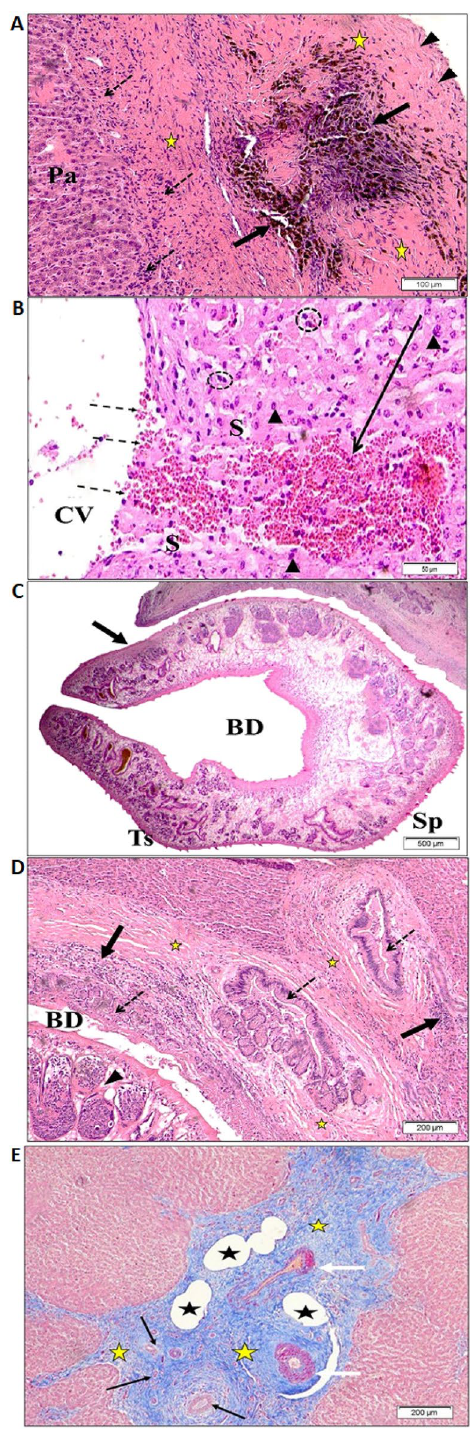
Figure 6. Light microscopic photographs of infected sheep liver stained with H&E. ( A ) thickened fibrous capsule (arrowhead) and capsule region of dark brownish hemosiderin pigment (arrows) with the marked proliferation of fibrous connective tissue (yellow stars). Inflammatory cells (dotted arrows) at the periphery of necrosed degenerated parenchymal hepatocytes (Pa); ( B ) part of dilated central vein (CV) with damage and loss of normal endothelial lining (dotted arrows). Note degenerated hepatocytes with dark stain nuclei (head arrows). Blood sinusoids showed enlarged Kupffer cells (dotted circle). Note massive hemorrhage at the site of necrotic hepatocytes (black arrow); ( C ) an adult fluke (arrow) in the lumen of the dilated bile duct (BD). Note the intact outer tegument (Ts) with embedded spines (Sp); ( D ) hyperplasia of the bile ducts (dotted arrows), extensive fibrosis of connective tissue (yellow stars) with heavy infiltration by various inflammatory cells (arrows). Note the presence of Fasciola worm (arrowhead) in the lumen of the dilated bile duct (BD). ( E ) Stained with Masson trichrome stain showing extensive fibrosis at portal region (yellow stars). Note the dilated lymphatic vessels (black stars), proliferated bile ducts (black arrows) and thickened walls of blood vessels (white